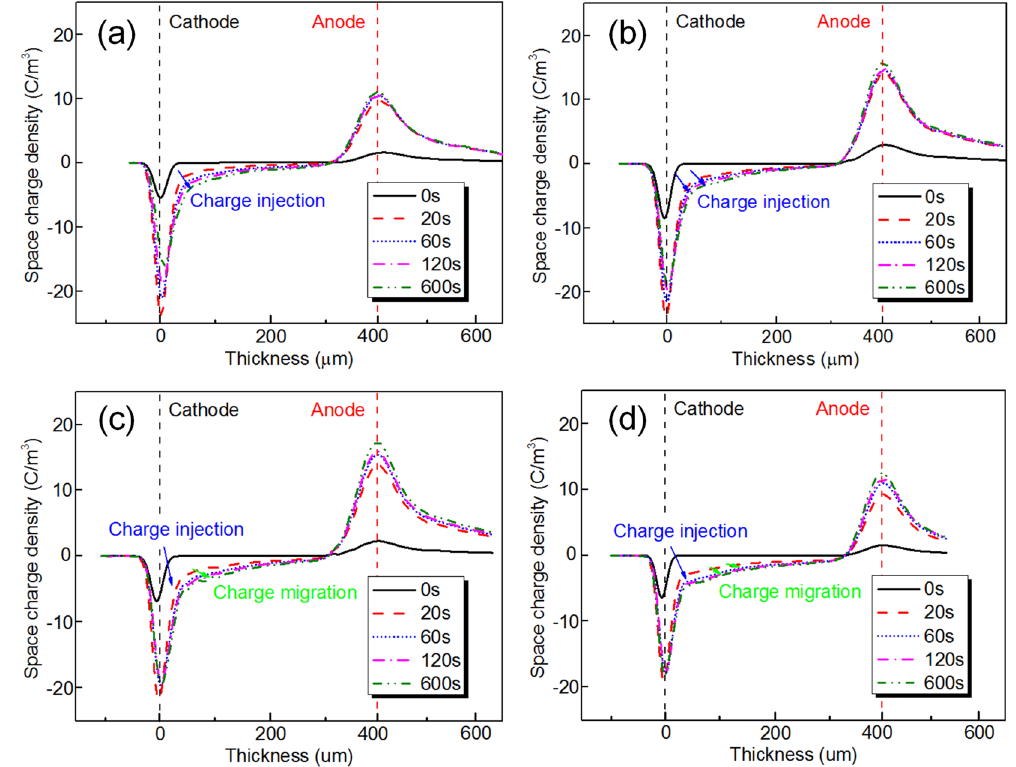
Figure 6. The space charge distribution of experimental samples subjected to a dc electric field of 40 kV·mm − 1 for 600 s under different temperature: ( a ) under temperature of 30 °C, ( b ) under temperature of 60 °C, ( c ) under temperature of 80 °C, and ( d ) under temperature of 100 °C.